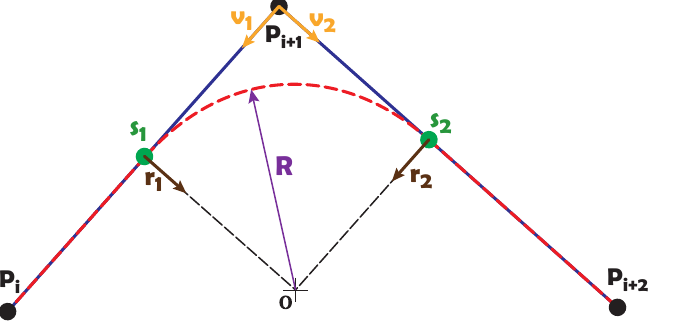
Figure 6. Radii of gyration: reference trajectory (blue), waypoints ( P ), smooth path (red), radius ( R ), center ( O ), and tangential points ( s